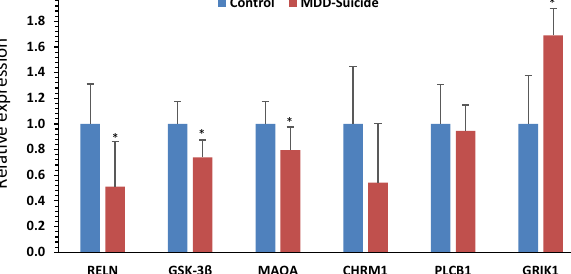
PFC, except for miR-20b-5p, appeared in the list of LC-associated miRNA changes in suicide subjects. Even the expression of miR-20b-5p was upregulated in LC in contrast to PFC, where its expression was downregulated. Moreover, the elevated levels of miRNAs was found to be responsible for the dysregulation of genes associated primarily with neurotransmitter systems such as glutamate and GABA 34 . Altogether, our results not only suggest a complex neuroanatomical nature of LC receiving various neurochemical inputs across various brain areas 35 but also indicate that suicide-associated changes in miRNAs are brain region specific and that miRNAs or associated gene networks in specific brain areas may have distinct functions in determining disease pathophysiology. Disease pathogenesis associated with psychiatric illnesses like suicidal behavior is a highly complex molec- ular process which involves a diverse array of dysregulation at both genetic and epigenetic levels 36, 37 . In order to have a deeper insight, a system level approach needs to be perused to explain the inherent nature of changes associated with this kind of molecular dysfunctionality 38 . MicroRNAs, as epigenetic modifiers, are capable of regulating large sets of genes through synergism 39 . This synergistic interaction between sets of miRNAs stems out from their same chromosomal localization and regulation by common cellular pathways 40 , which allows one to build a co-relational network which could be disease specific. This is supported by our data in which we identified pairs of miRNAs that were co-regulated in their expression across individuals within a single group (control or suicide). The pairwise correlations for all miRNAs were computed within the control group as well as within the suicide group separately. We were particularly interested in identifying miRNA pairs that showed no